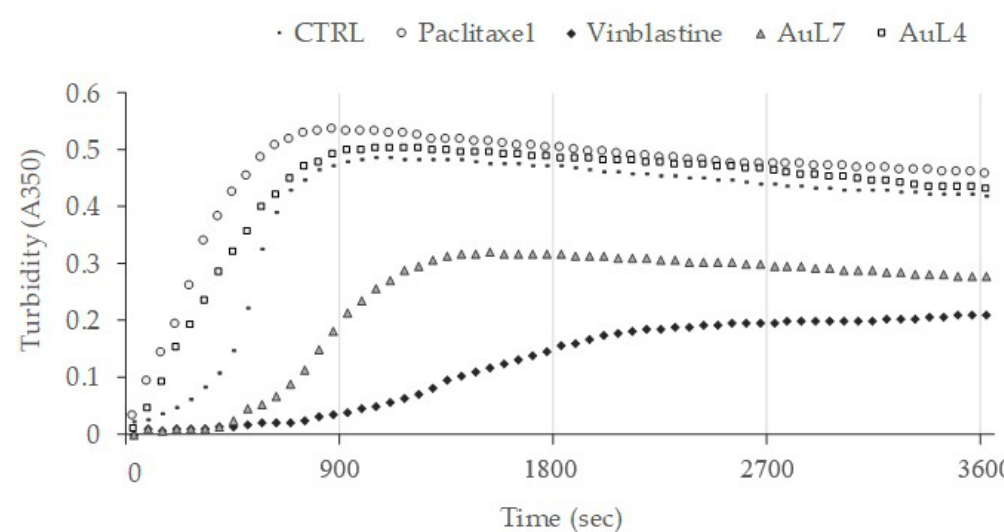
Figure 4. Tubulin-polymerization assay. The e ff ect of compounds AuL4 and AuL7 on in vitro tubulin polymerization was evaluated. Two positive control molecules, Paclitaxel and Vinblastine, were used as tubulin-stabilizing and tubulin-destabilizing agents, respectively. DMSO was used as a negative control. Assembly of tubulin into microtubules was determined by measuring the turbidity at 350 nm for 3600 s at 37 ◦ C. All the compounds were used at a concentration of 10 µ